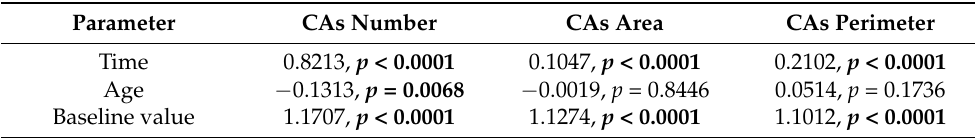
Table 2. Coefficients and p -values of the multiple linear regression analysis conducted on the variation of the CAs number, area and perimeter over time; the model also included the patient’s age and baseline value of the measure; statistically significative values are in bold.